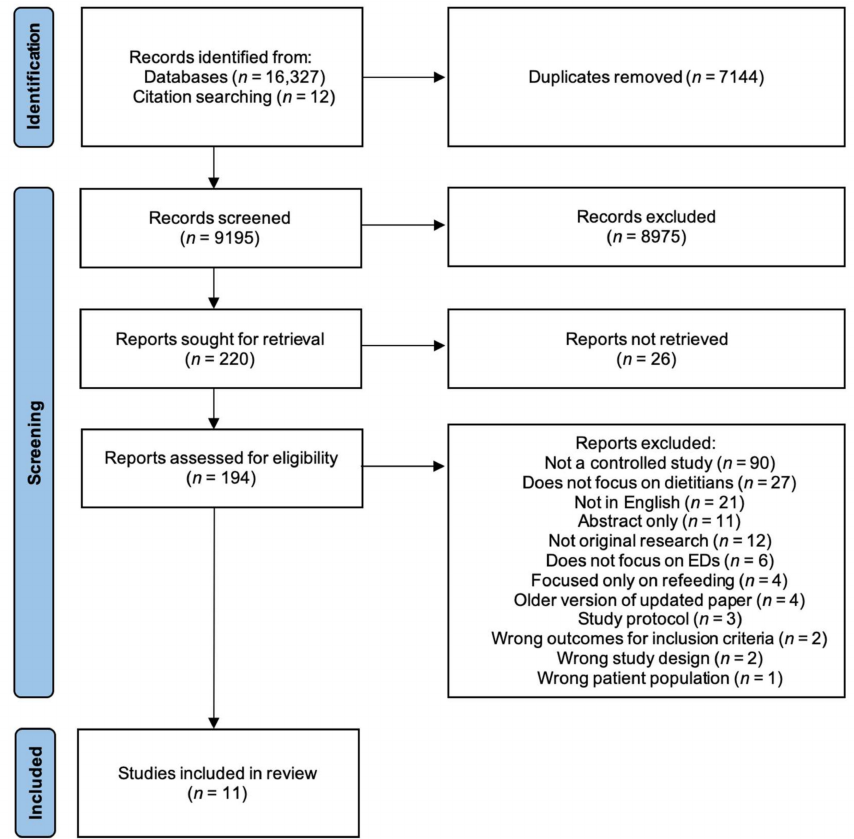
Figure 1. Identification and selection of articles